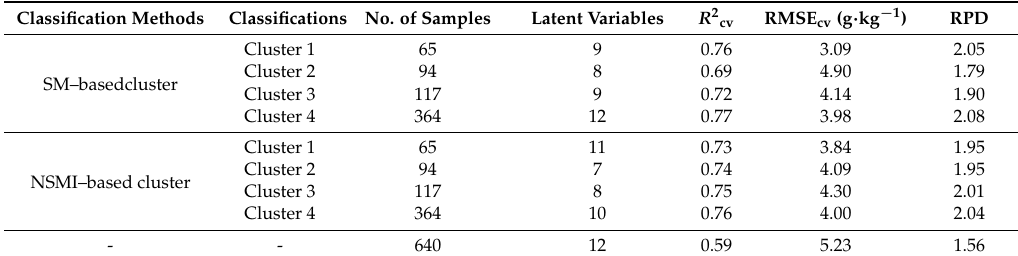
Table 3. PLS-SVM cross-validation results for SOM estimation based on SM–based cluster method, NSMI–based cluster method, and the entire calibration dataset ( n =